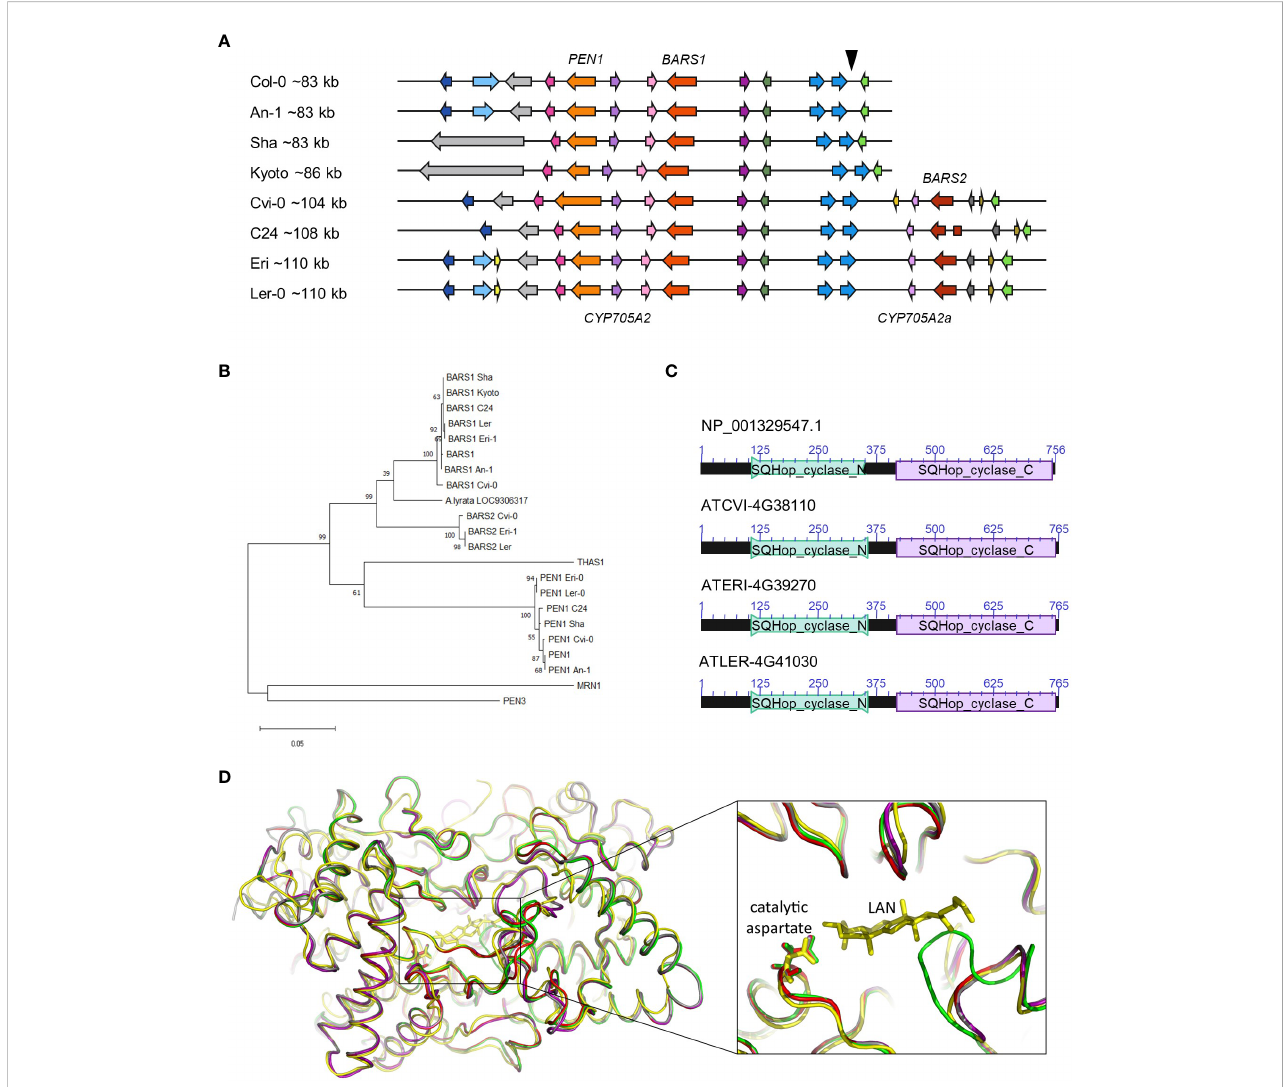
FIGURE 3 BARS2 is a BARS1 duplicate absent from the reference genome and encodes oxidosqualene synthase. (A) Organization of arabidiol/baruol gene cluster in Col-0 and seven nonreference accessions. The genomic insertion including CYP705A2a and BARS2 genes is marked with a triangle above the reference cluster. (B) Phylogeny of amino acid sequences of clade II OSCs residing in clusters. BARS1 ortholog from A.lyrata (LOC9306317) is included. The maximum likelihood tree was generated using the MEGA11 package with Jones-Taylor (JTT) substitution matrix and uniform rates among sites. Values along branches are frequencies obtained from 1000 bootstrap replications. (C) Conserved protein domains encoded in BARS1 (Col-0) and BARS2 (Cvi-0, Eri-1, Ler-0) genes. SQHop_cyclase_N - squalene-hopene cyclase N-terminal domain (Pfam 13249). SQHop_cyclase_C - squalene-hopene cyclase C- terminal domain (pfam13243) (D) 3D models of baruol synthase proteins encoded by BARS1 and BARS2 , predicted by ColabFold software, superposed with the crystal structure of human oxidosqualene cyclase in a complex with lanosterol (LAN). The enlargement box highlights the positions of the catalytic aspartate residue in the predicted models. Colors mark superposed models: green (Col-0 BARS1 isoform NP_193272.1), red (Col-0 BARS1 isoform NP_001329547.1), purple (Cvi-0 BARS1 ATCVI-4G38020), grey (Cvi-0 BARS2 ATCVI-4G38110) and yellow (human OSC PDB ID: